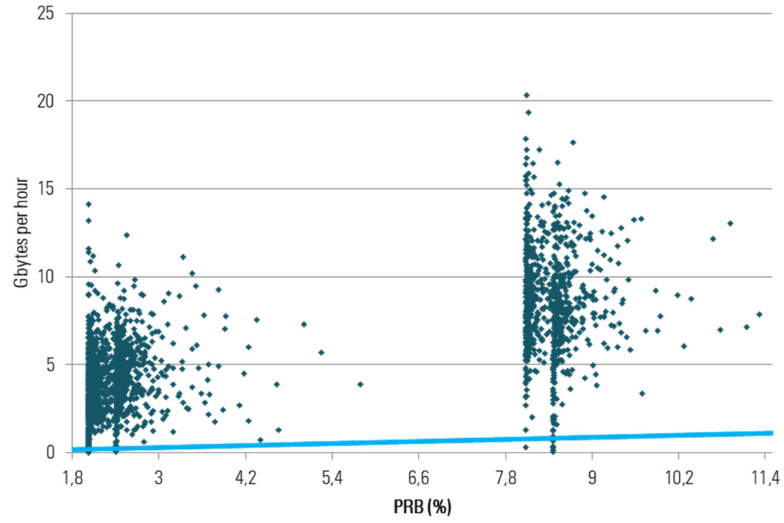
Figure 9. Cell throughput vs. PRBs used (theoretical and empirical) for 10 MHz.